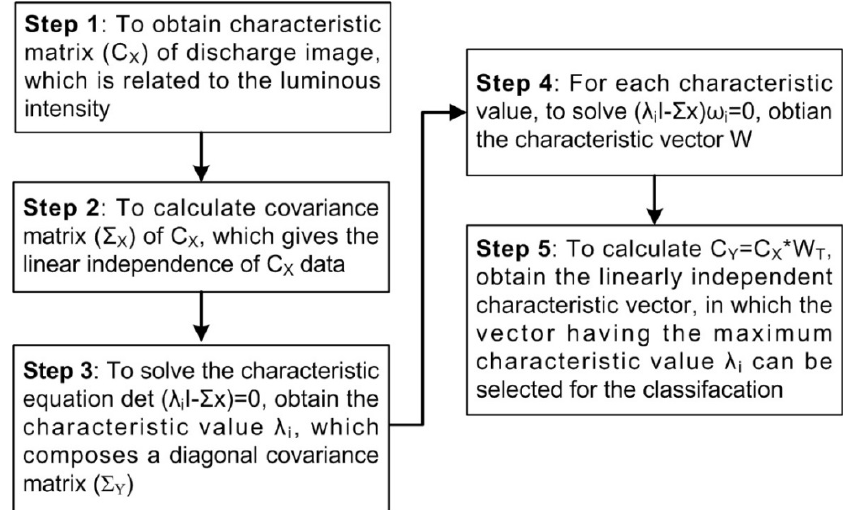
Figure 3. Flowchart of discharge characteristic analysis based on the principal component analysis method.